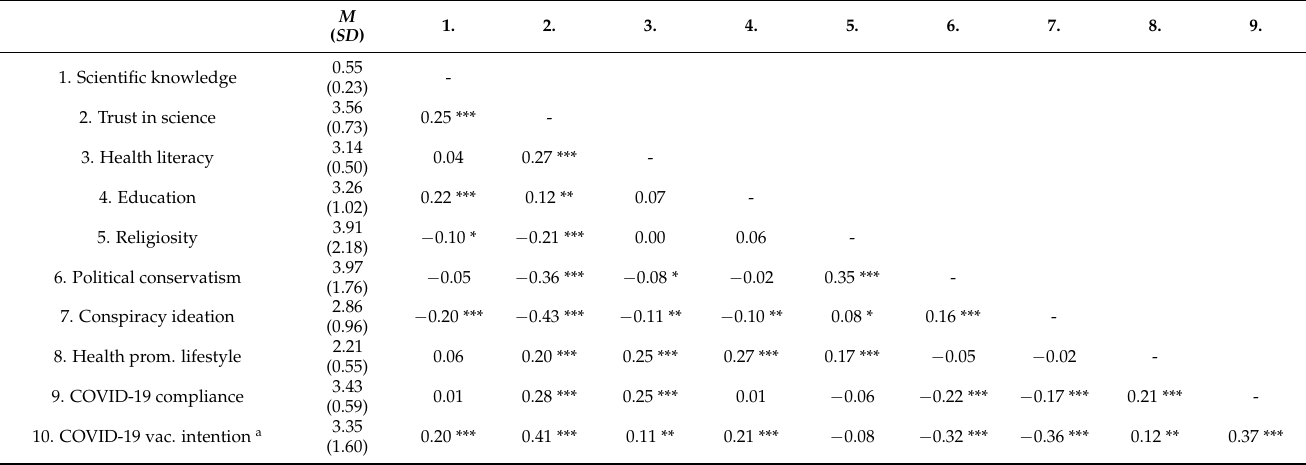
Table 1. Basic descriptive statistics and correlations between variables.